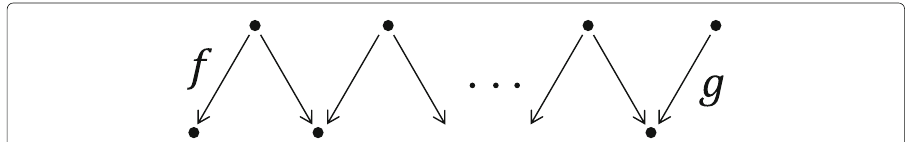
Fig. 3 Lateral paths are defined between two arcs, not between two nodes. A lateral path between two arcs f and g is a sequence of arcs between them such that successive arcs have a common target node or source node